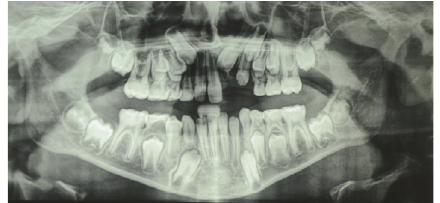
Figure 8: OPT of the patient during follow-up (1 year postextrac-